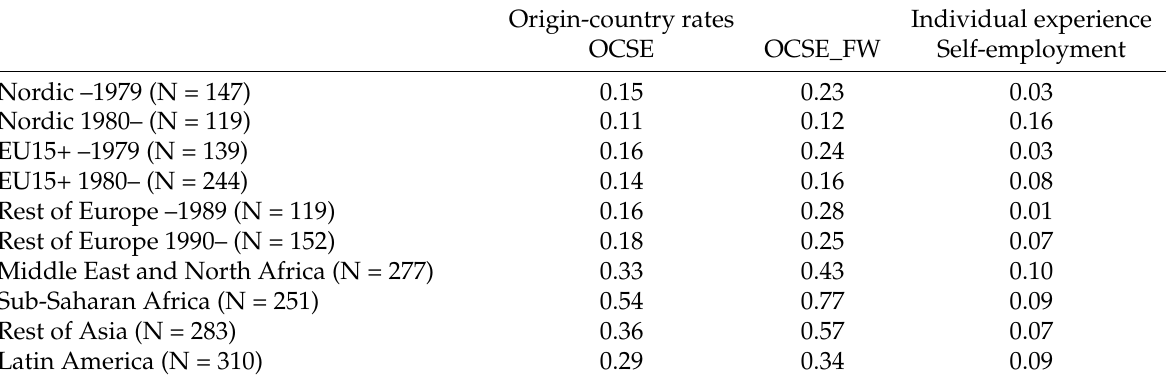
Table 2: Rates of self-employment before migration